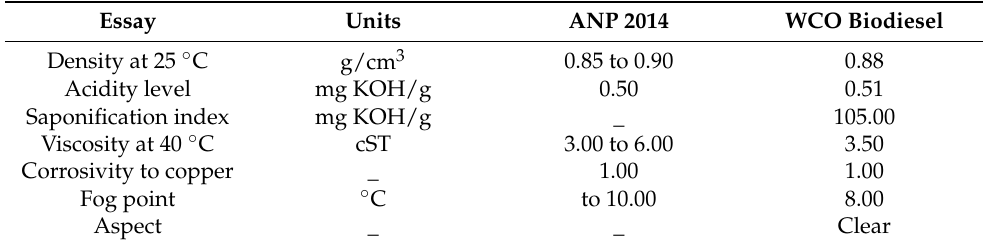
Table 4. Physicochemical analysis of the biodiesel produced.